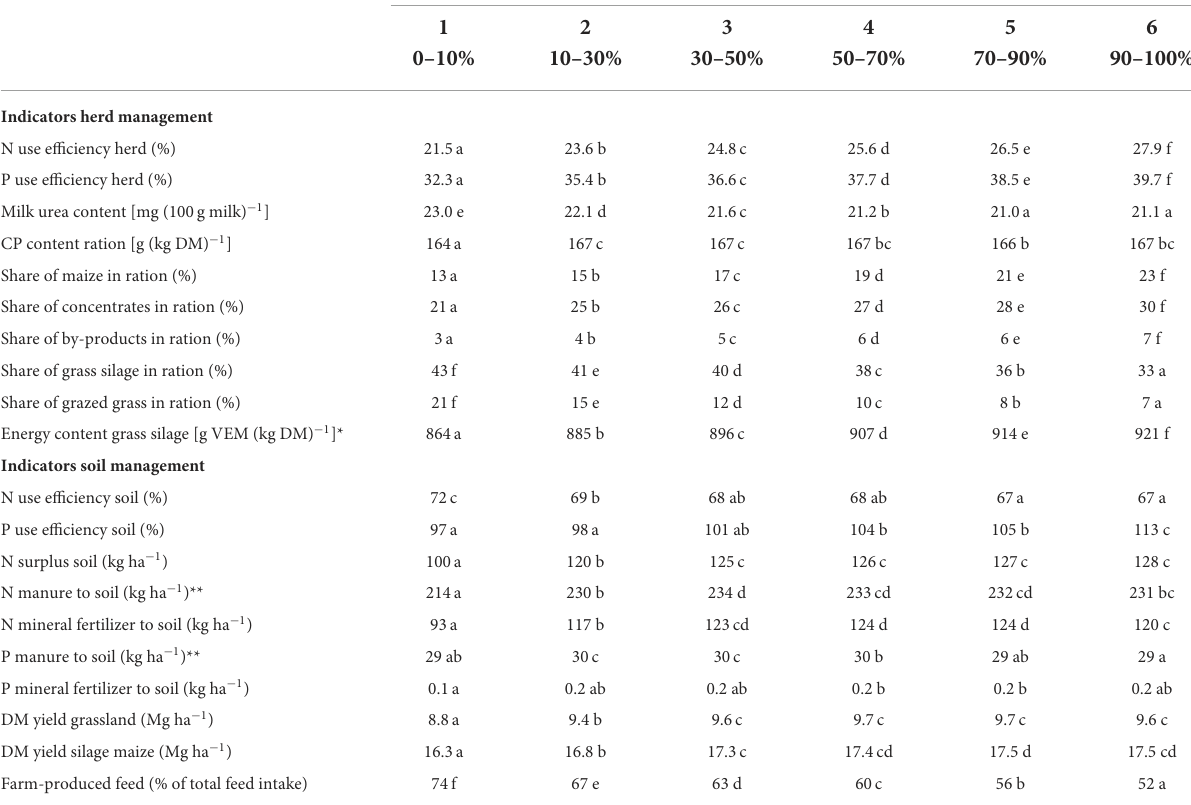
TABLE 2 Mean performance indicators of herd management and soil and crop management of 12,770 dairy farms for the year 2020.